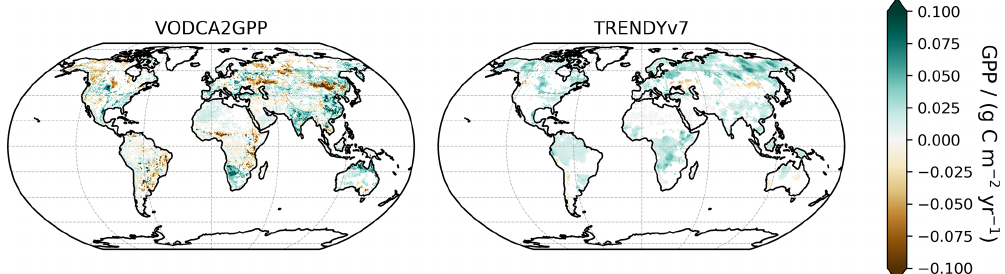
Figure A5. Global maps of yearly median GPP trends for the period 1988–2016 for VODCA2GPP and TRENDY-v7. White indicates non-significant trends.